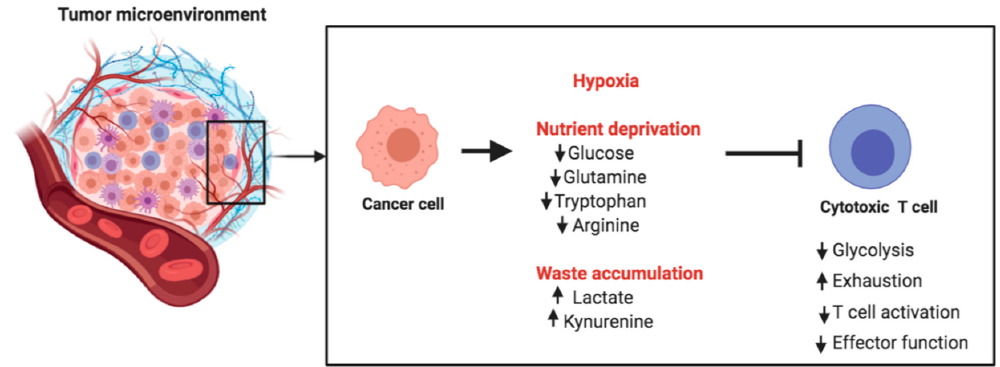
Figure 4. Metabolic challenges encountered by T cells in the tumor microenvironment. Cancer cells compete with tumor-infiltrating T cells for key nutrients that are also required for optimal T cell function. Tumor cells utilize aerobic glycolysis for their energetic requirements, thereby producing lactate as a byproduct in the extracellular milieu and acidifying the tumor microenvironment (TME). Thus, tumor-infiltrating T cells face multiple metabolic challenges in the hypoxic, acidic, and nutrient-deprived TME. Since glutamine is important for cancer cells, it has been an attractive therapeutic target for decades, but prior attempts to block glutamine metabolism in cancer patients have resulted in unacceptable toxicity [148]. A problem with using metabolic inhibitors in cancer therapy is that most metabolic pathways are not purely confined to cancer cells. Therefore, they can have toxic effects on non-cancerous cells. In a recent study, Leone et al. designed a prodrug form of the glutamine